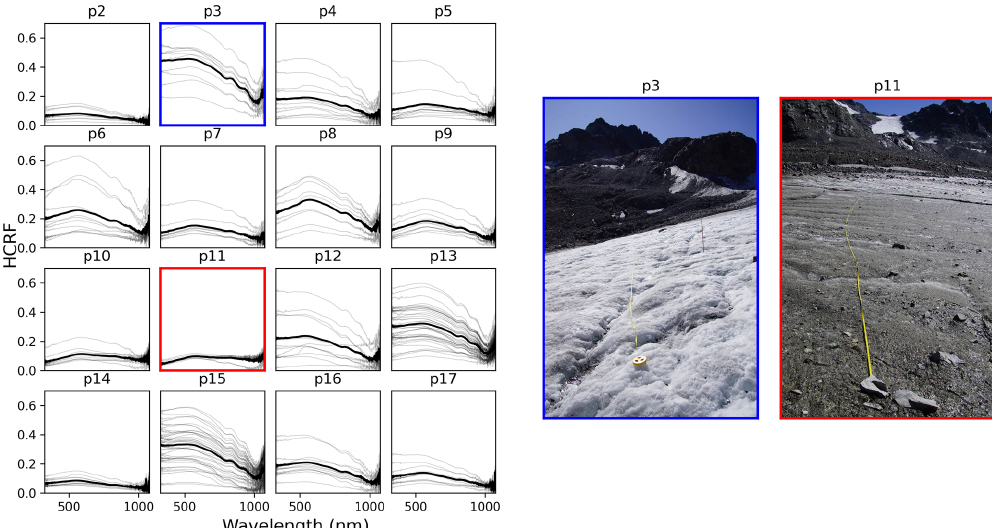
Figure 3. Each subplot on the left shows the spectra along a profile line. The bold black lines highlight the mean spectral reflectance (HCRF) in each profile. Photos of the ice surface along p3 and p11 are shown on the right for visual context. Photos were taken at the time of the respective measurements by Andrea